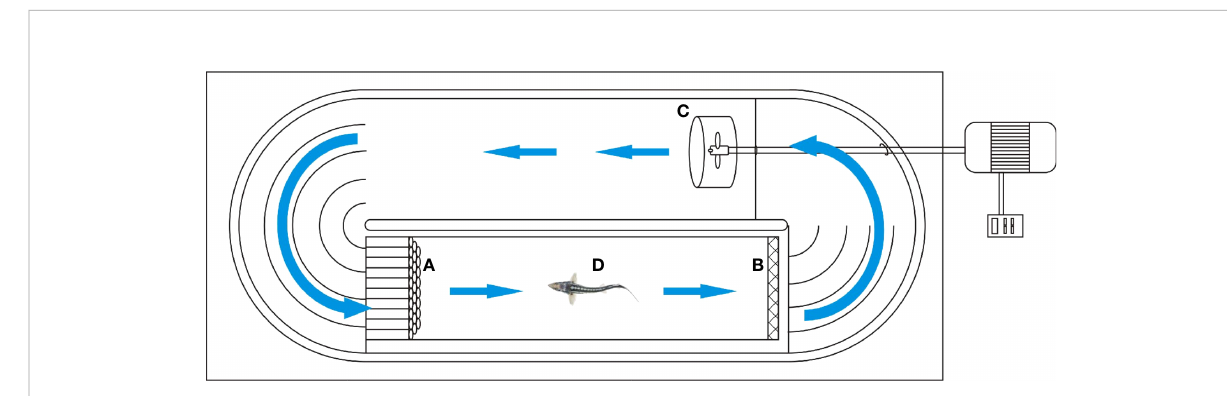
FIGURE 2 Experimental apparatus for testing swimming performance. (A) is the recti fi er; (B) is the wire mesh; (C) is the propeller; (D) is the swimming test area (50cm×10cm×10cm); The frequency converter controls the motor, and the motor controls the three-blade propeller to create water fl ow, and the water circulates in the oval swimming tank, and the direction of the blue arrow is the direction of the water fl ow.